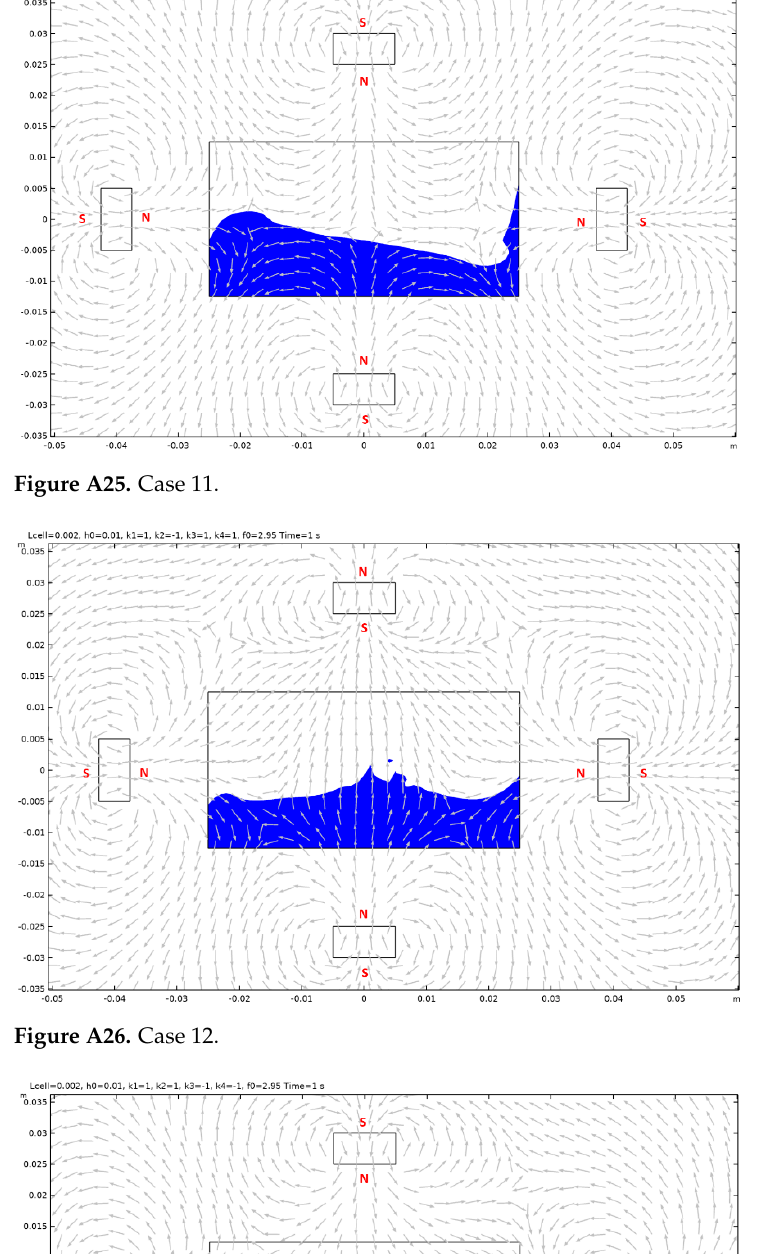
Figure A24. Case 10.